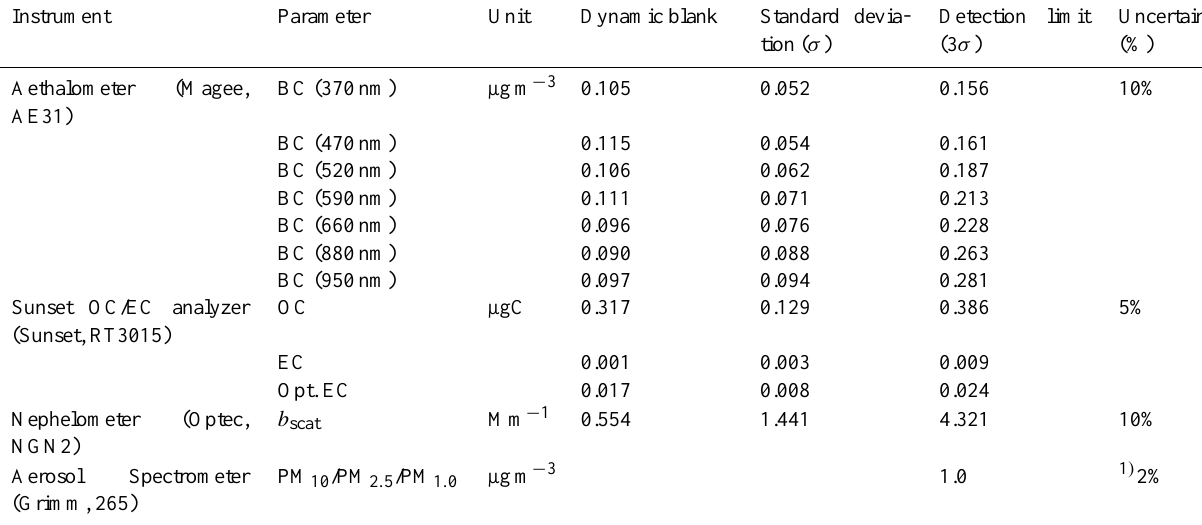
Table 2. Detection limit and uncertainties of the measurement parameters. Instrument Parameter Unit Dynamic blank Aethalometer